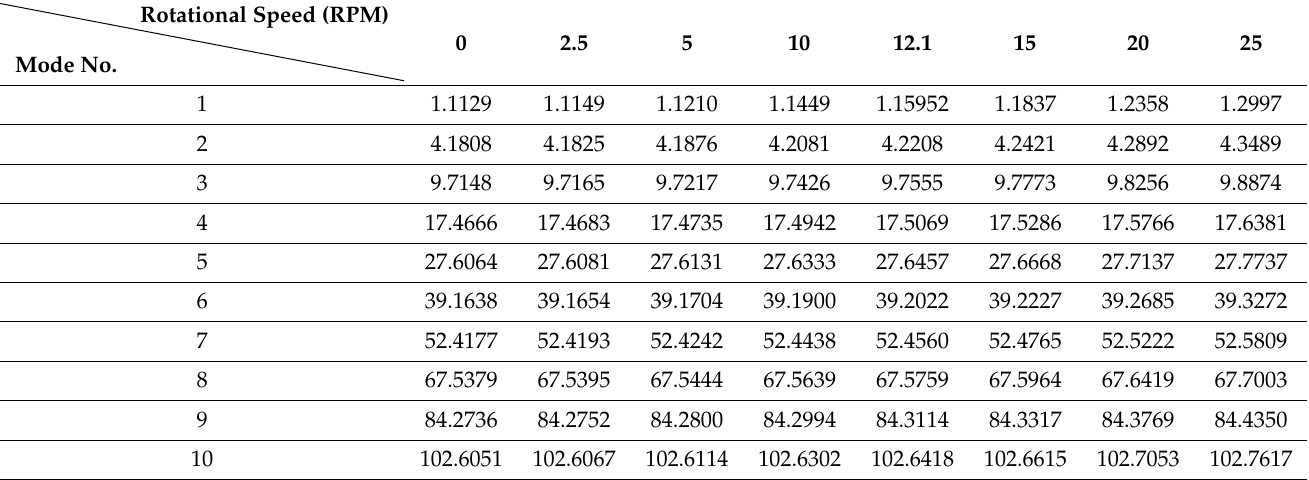
Table 2. The first ten natural frequencies (Hz) in the edge-wise direction as a function of rotor speed Ω = ( 0 to 25 RPM ) ) of NREL 5 MW HAWT